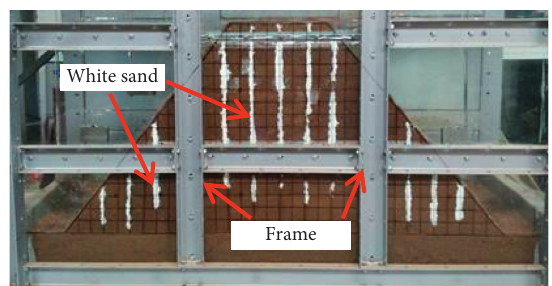
Figure 2: Shaking table test model of the double-side slope.